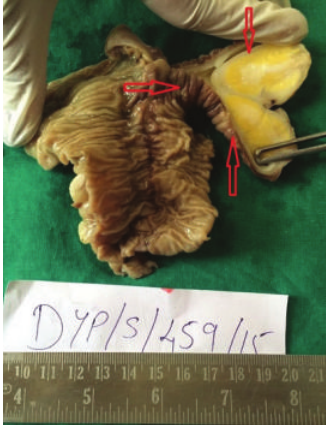
Figure 4: Specimen cut open revealed a pedunculated lipoma of the small bowel.